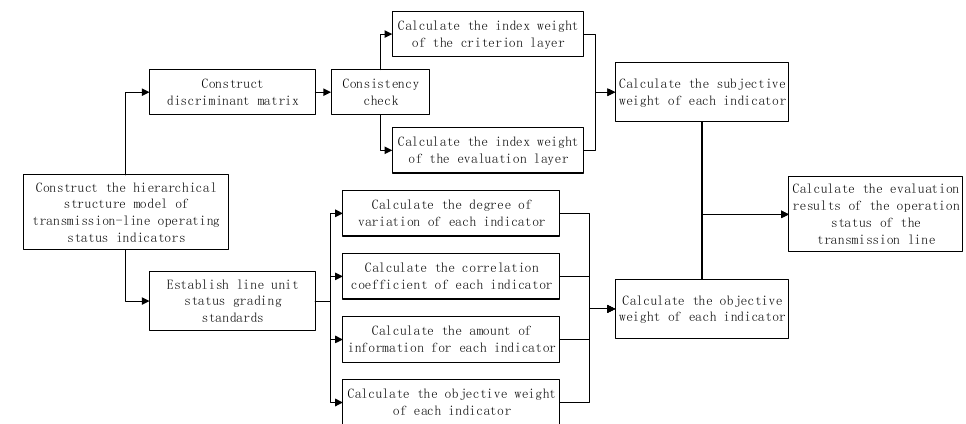
Figure 2. Comprehensive evaluation method of online monitoring.